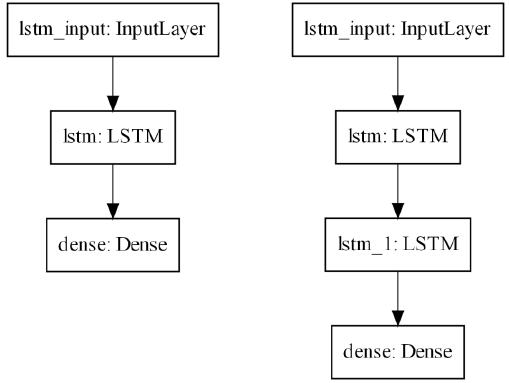
Figure 7. Models of Sequential class used in this paper.